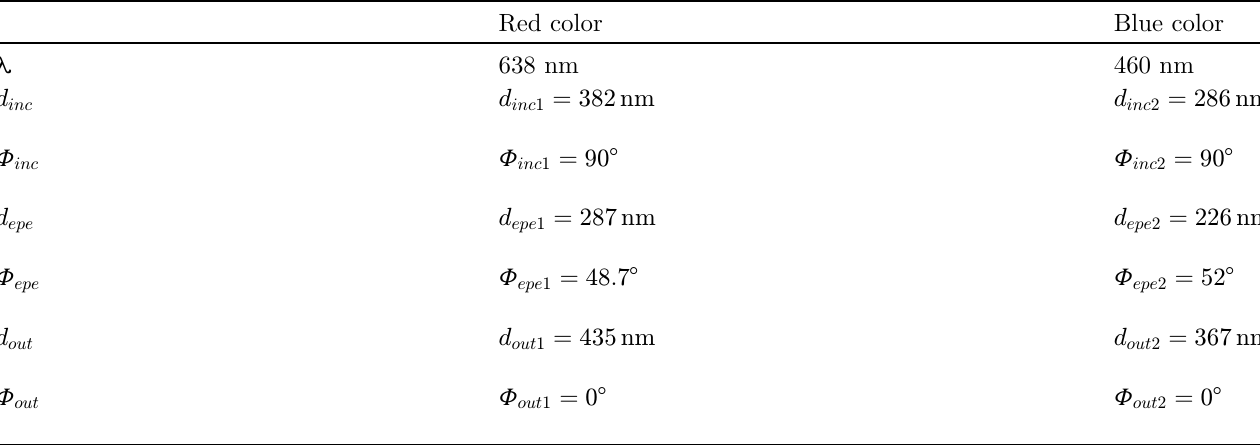
Fig. 15. (a) Single EPE grating including several subgratings; (b) cross-sectional view of re fl ective subgrating unit cell. Table 1. Parameters of the full-color system of